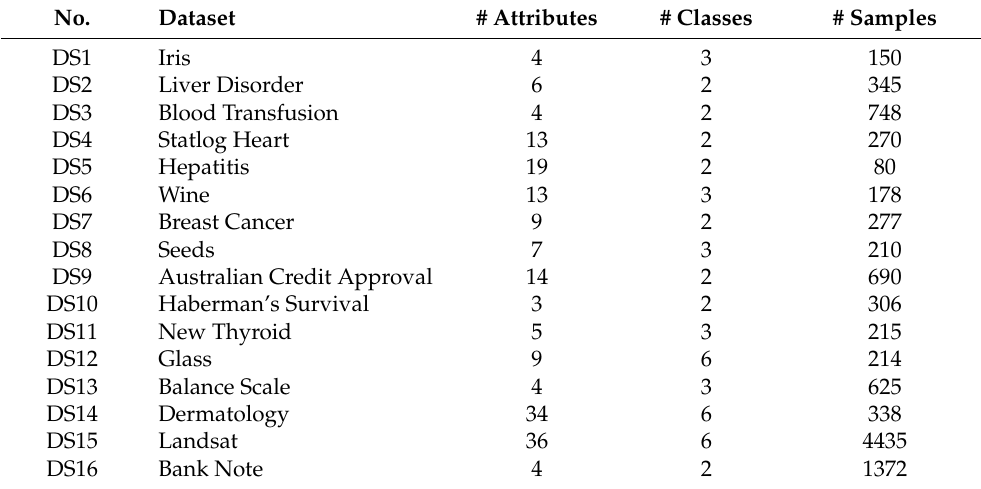
Table 10. Properties of datasets selected for ANN model